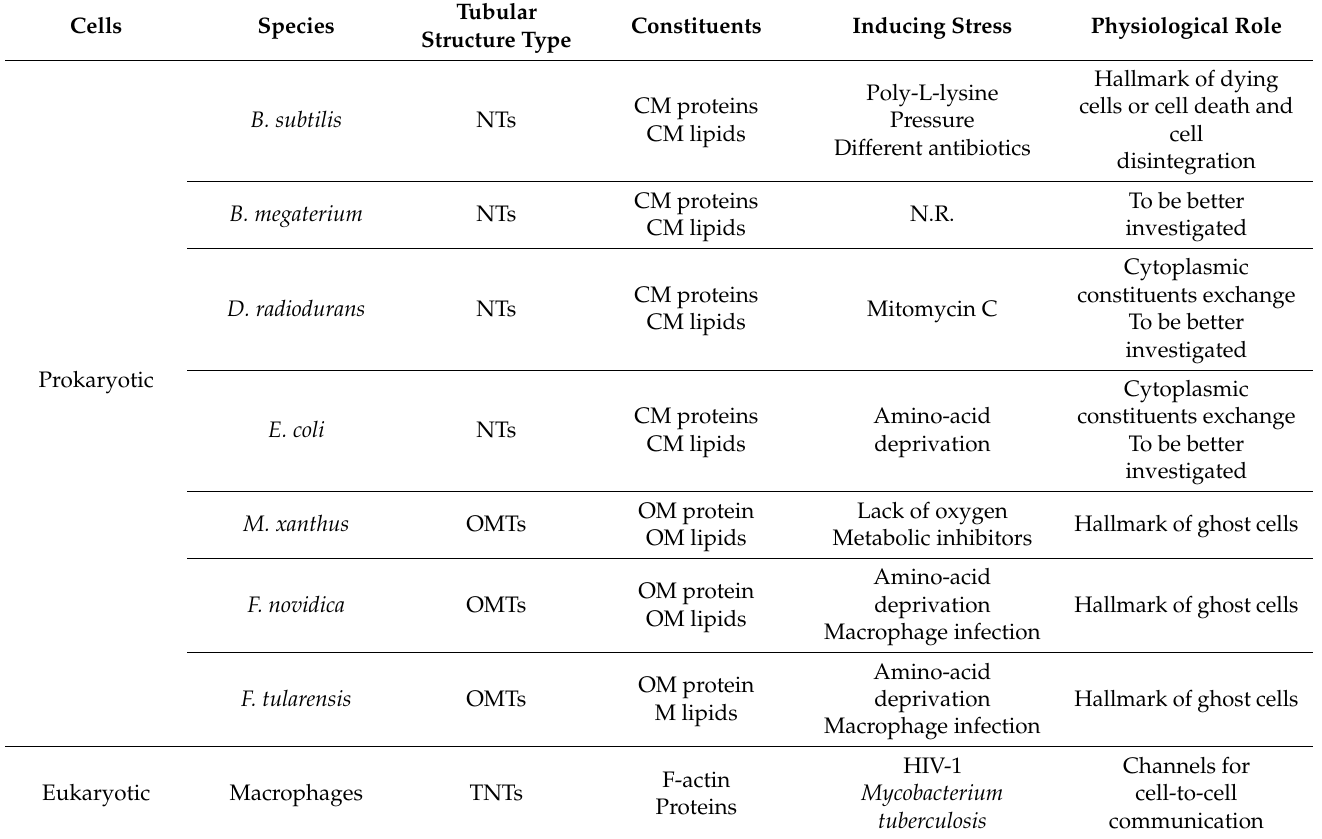
Table 6. Cells reported to produce membranous tubular structures inducted by some type of